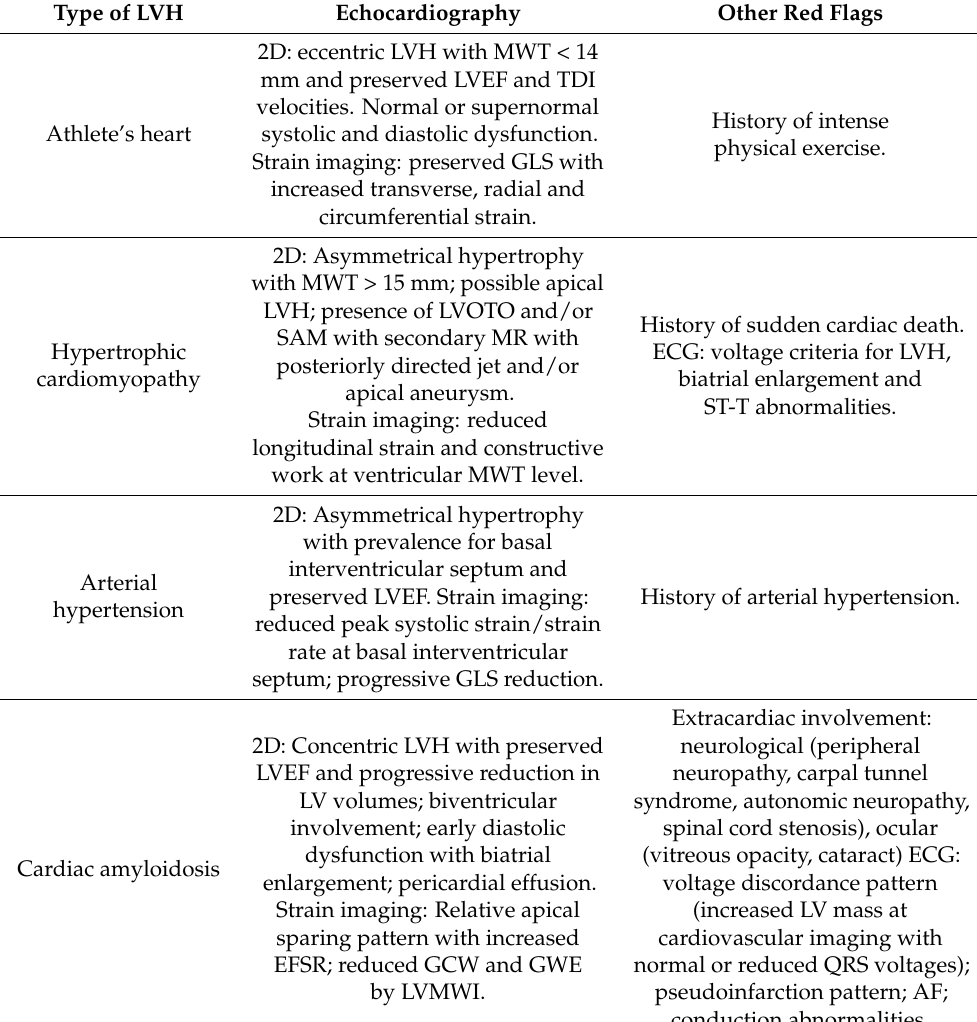
Table 1. Echocardiographic features of the different causes of left ventricular hypertrophy in adults. Type of